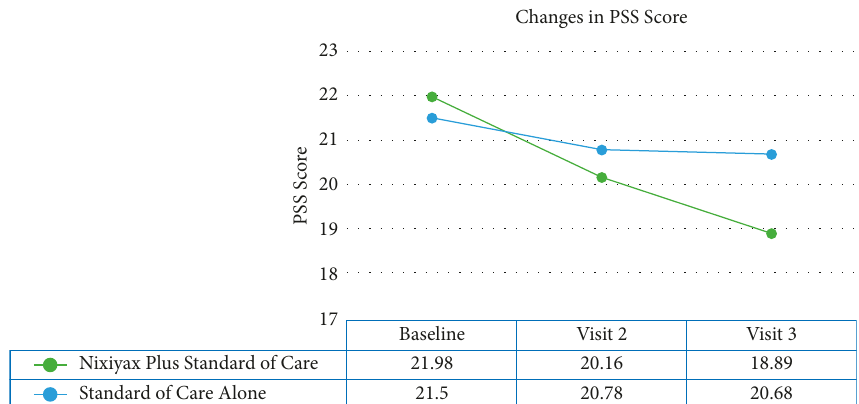
Figure 4: Changes in PSS scores over the course of the visits. A significant decrease in PSS scores was observed in the Lactium ™ plus standard of care group, whereas the change in the PSS scores in the standard of care alone group was not significant.